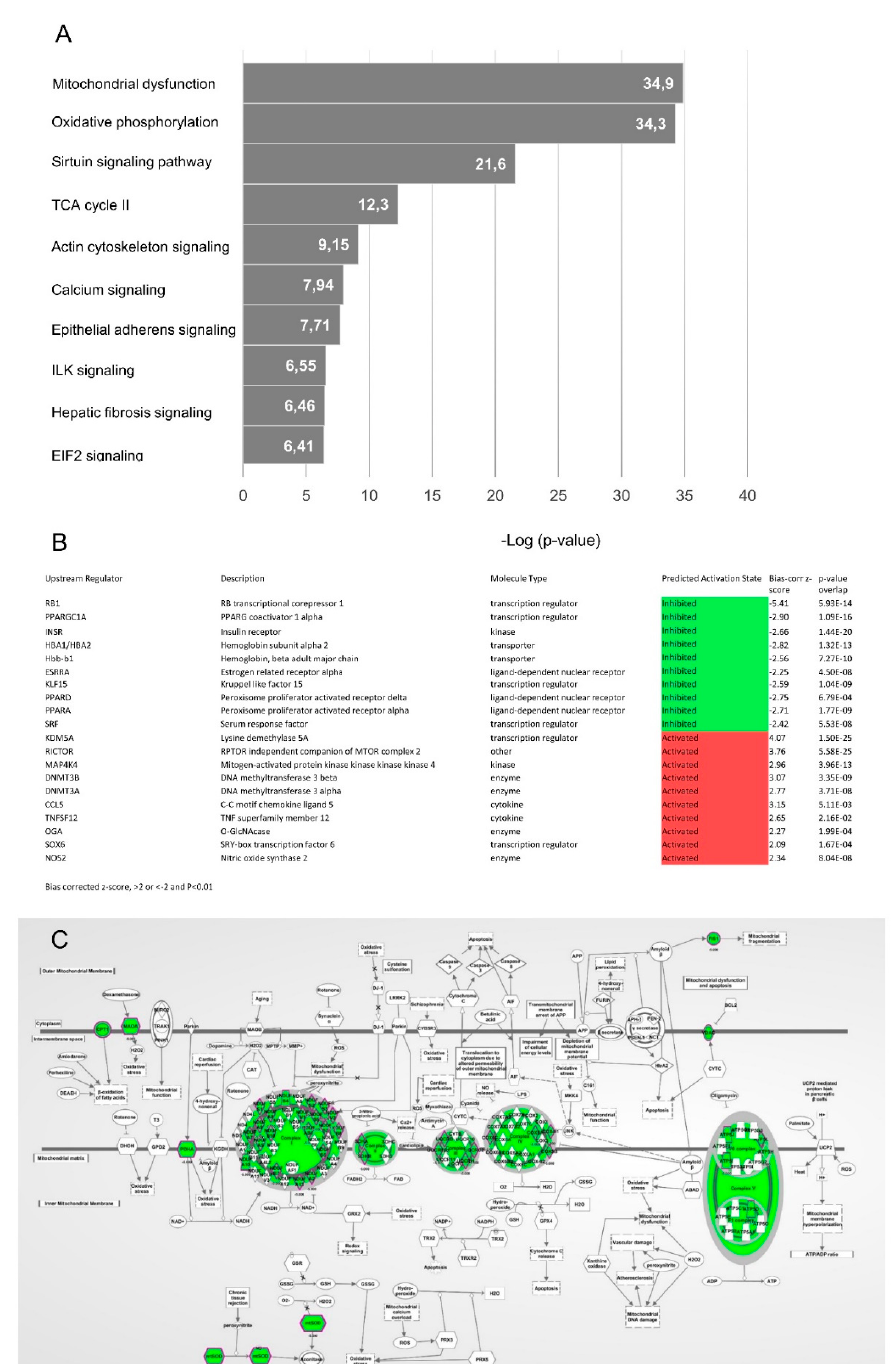
Figure 4. Expression analysis of proteomics data. ( A ) Graph depicting the top 10 canonical pathways ( p -value < 0.01) derived from an IPA analysis based on differentially regulated proteins in aortic samples from MFS patients compared to controls. ( B ) Table depicting predicted activation or inhi- bition of key upstream transcriptional regulators (bias-corrected z-score >2 or < − 2, p -value < 0.01) derived from an IPA analysis based on the observed protein expression changes. ( C ) Mitochondrial dysfunction network representation derived from